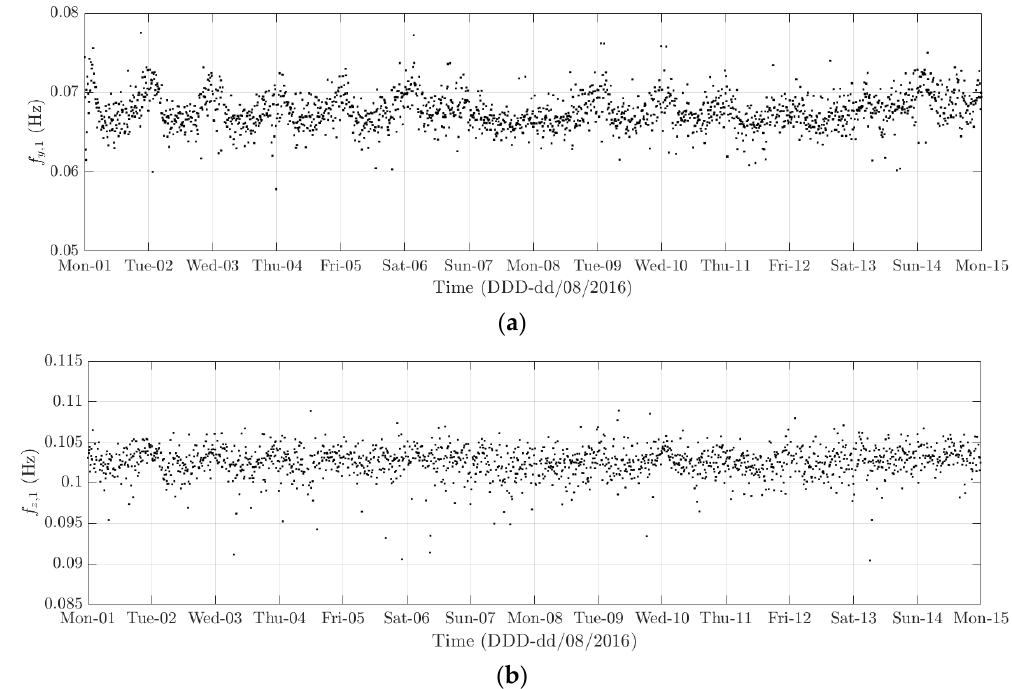
Figure 22. Variation of the 10 ‐ min natural frequencies of ( a ) the first lateral mode and ( b ) the first heaving mode from 1 to 14 August 2016.